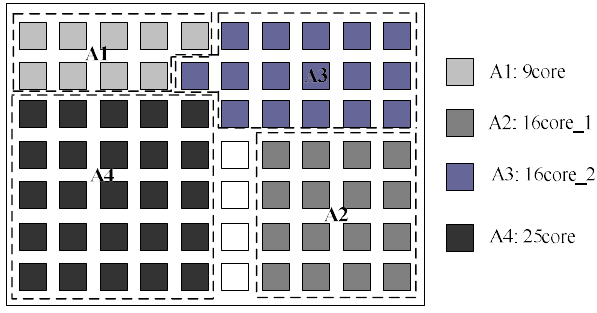
Figure 5. The placement generated by the approach in [4].